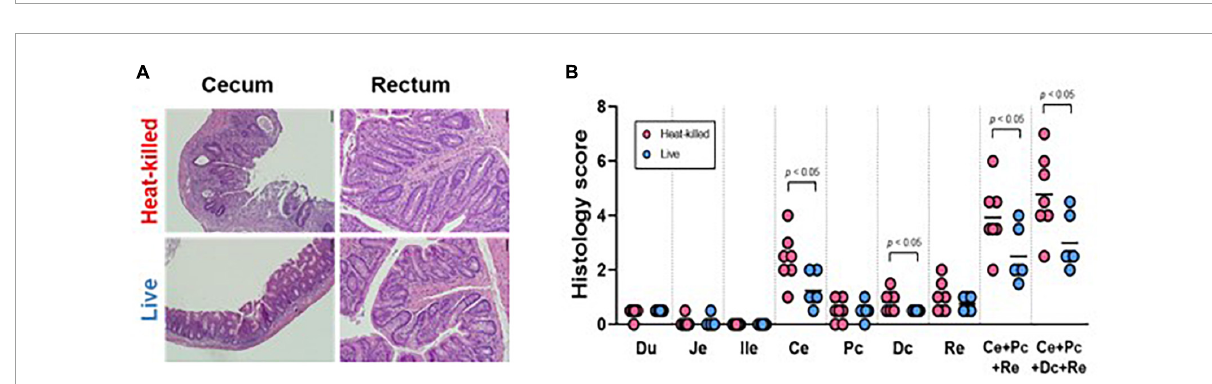
FIGURE9 (A) Representative histology pictures taken of the cecum and the rectum of mice seeded with the SIHUMI consortium and administered heat-killed or viable EE-phage and (B) histology scores of the duodenum (Du), jejunum (Je), ileum end (ile), cecum (Ce), proximal colon (Pc), distal colon (Dc), rectum (Re), combined scores. The bar indicates the mean. A two-tailed unpaired t -test was performed, with statistical significance recorded as * p <